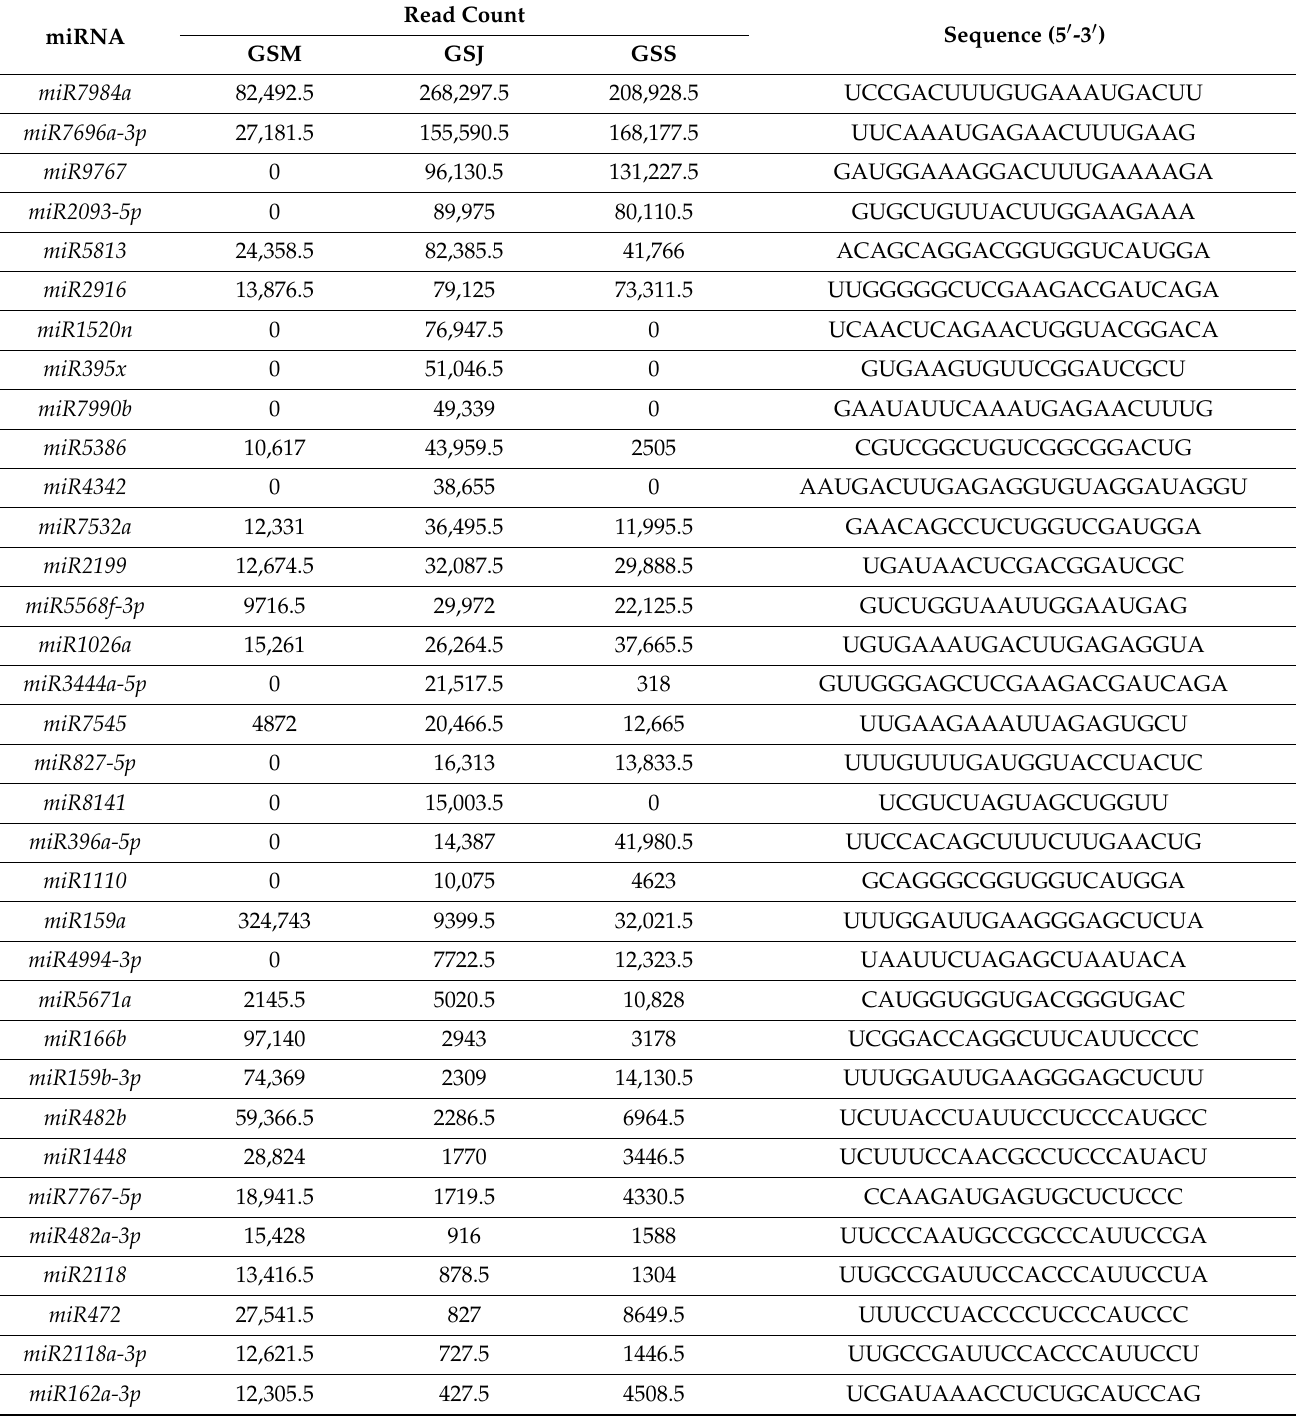
Table 2. Highly expressed conserved miRNAs in G. sinensis pods with different developmental